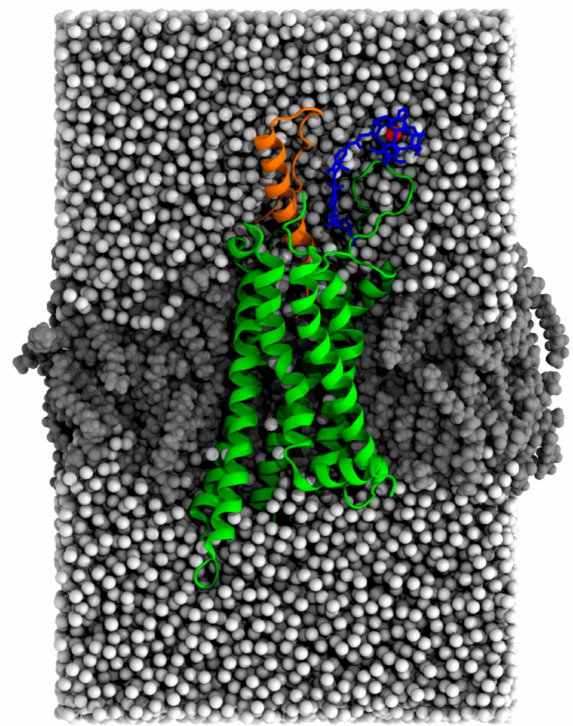
Figure 4. Snapshot (97,116 atoms) of the equilibrated Y2R-A202C-CrA system in complex with NPY after all restraints were released for 5 nanoseconds. Y2R is shown in green, NPY in orange, CrA in blue, the xenon atom in red, water in white, and lipids in